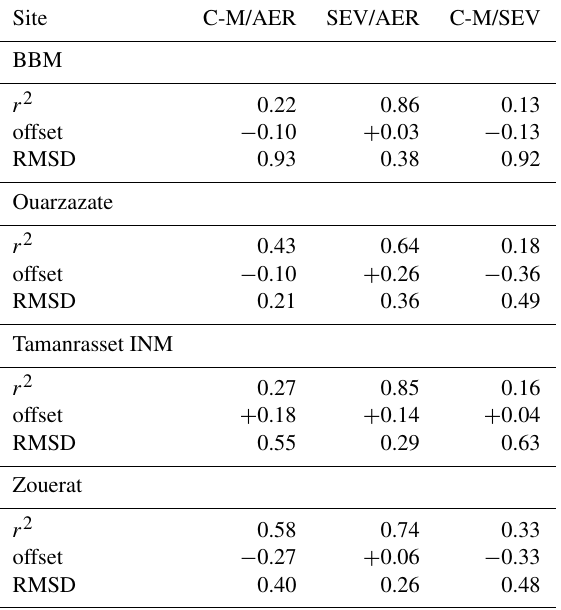
Table 3. COSMO-MUSCAT (C-M) and SEVIRI (SEV) AOD com- parisons with AERONET (AER). The mean AODs specified using AERONET data for the four sites are(with numbers of points in the comparisons in parentheses): 0.97 at BBM (85), 0.22 at Ouarzazate (213), 0.41 at Tamanrasset INM (250), and 0.55 at Zouerat (229).